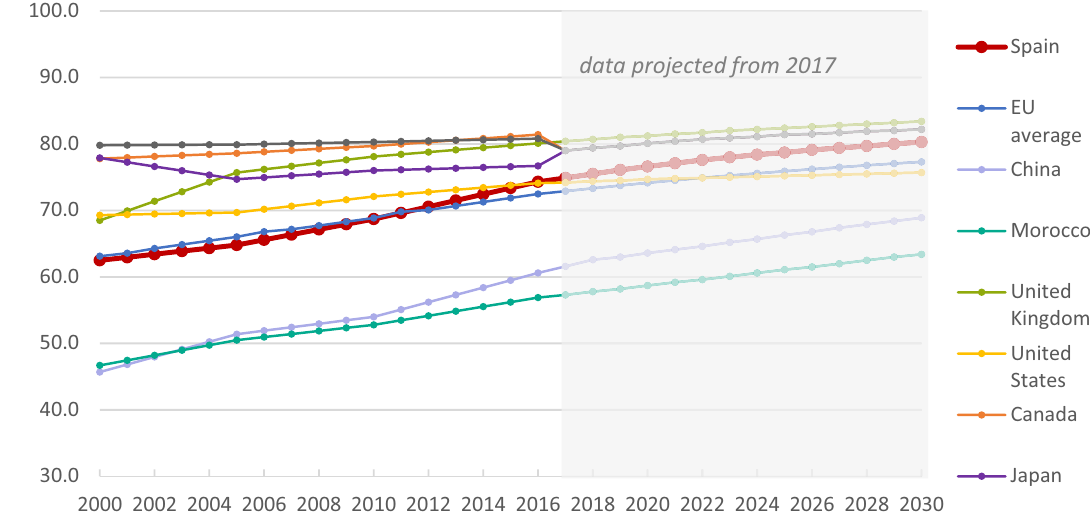
Figure 5. Trends in the Sustainable Development Goal health-related index score for Spain and comparator geographies from 2000 to 2017, with projections to 2030. EU, European